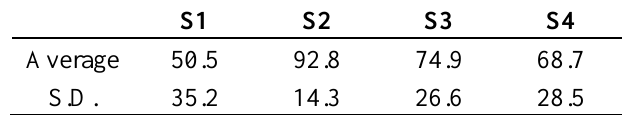
Table 1. Average and standard deviation for Statements 1 to 4 of the preliminary survey. S1 S2